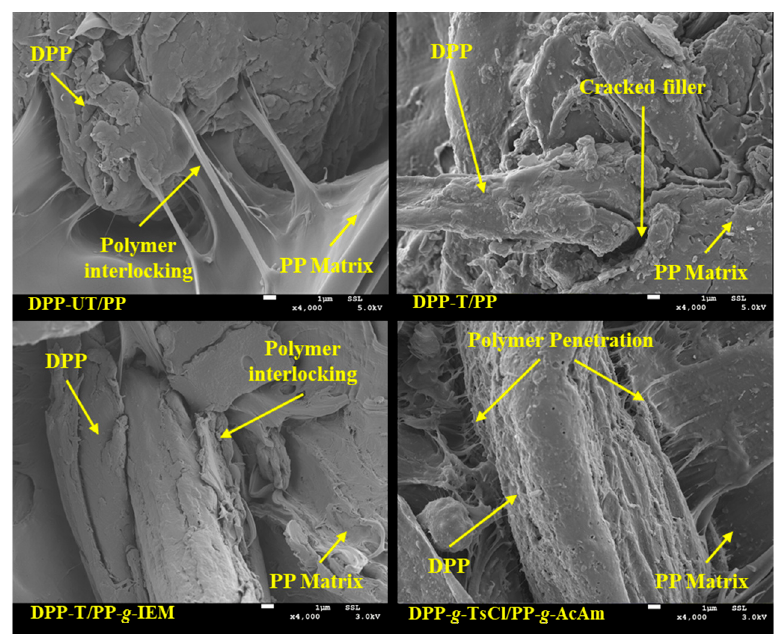
Figure 8. SEM micrographs of fractured surfaces of the tested tensile specimens.